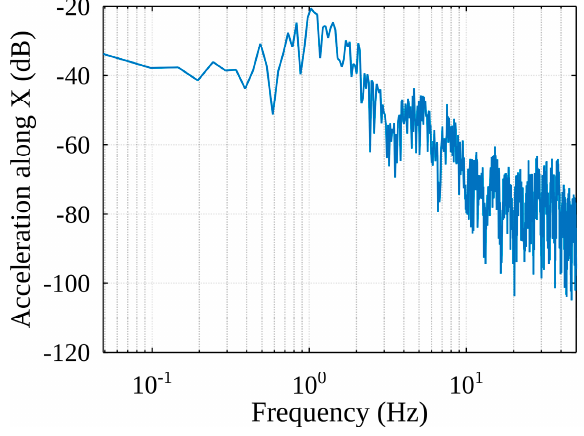
Figure 12. The spectrum of Acceleration along the X-axis (full handling process). However, to support the methodology in the initial stage of the handling inside the hull of the ship, only data from the vertical movement between sections 2 and 3 (Figure 7) were considered. In the summarized acceleration spectrum formed by analyzing the targeted 17 cycles, a similar situation is observed (see Figure 13), namely the range of the dominant component from 0.4 Hz to 2.5 Hz, which is (very likely) generated by the free oscillations of the container.